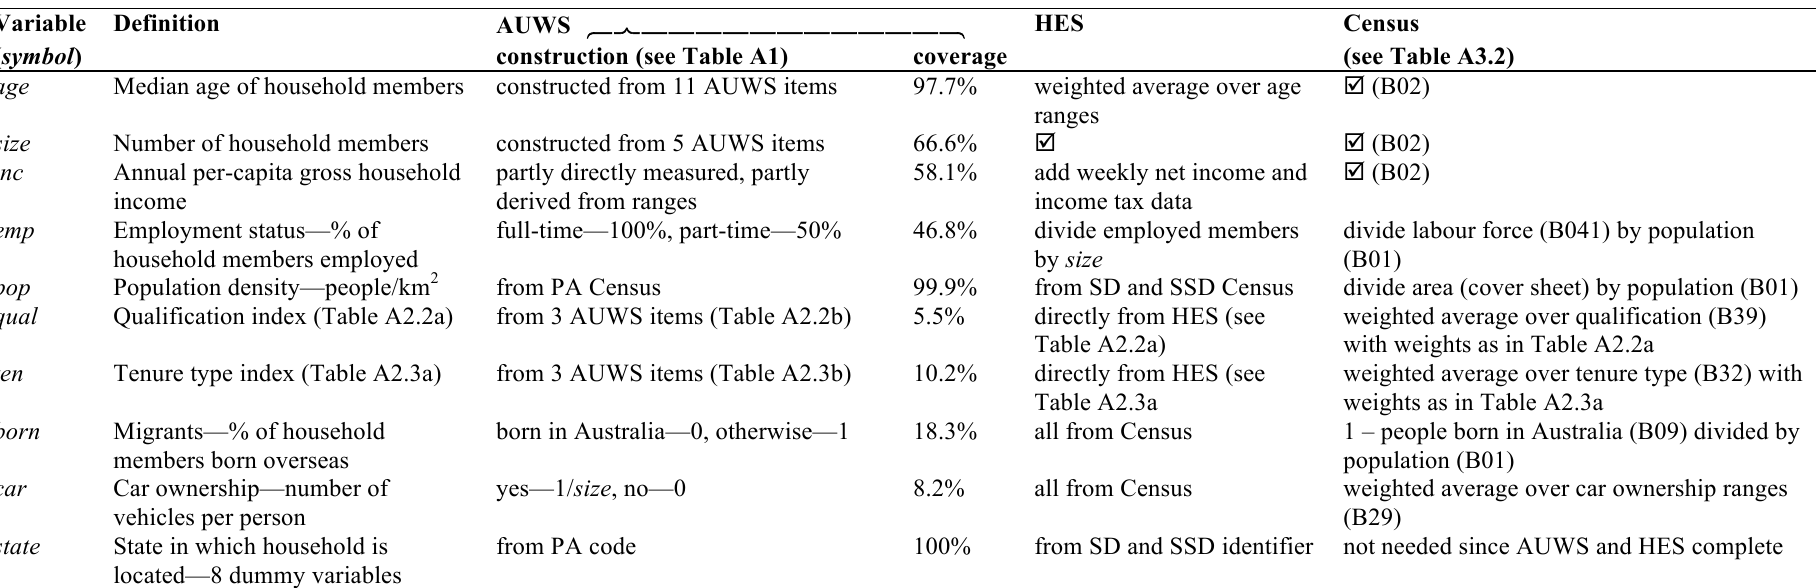
Table 1. Explanatory variables derived from companion data common to all surveys. There are 17 variables in total—9 socioeconomic-demographic variables, and 8 State dummy variables. The table describes how variables were constructed from raw data; þ indicates that variable exists as raw data item. In addition, the AUWS coverage indicates what percentage of missing data had to be filled with Census information. PA = Postal Area, SD = Statistical Division, SSD = Statistical